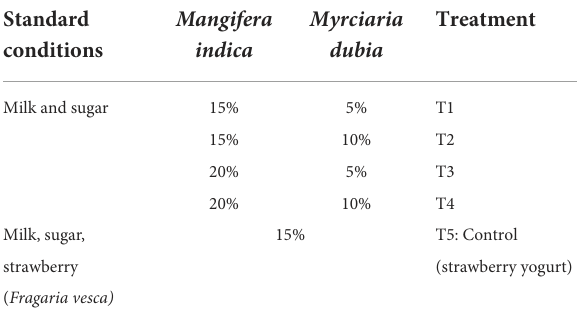
TABLE 2 Bi-factorial experimental design with